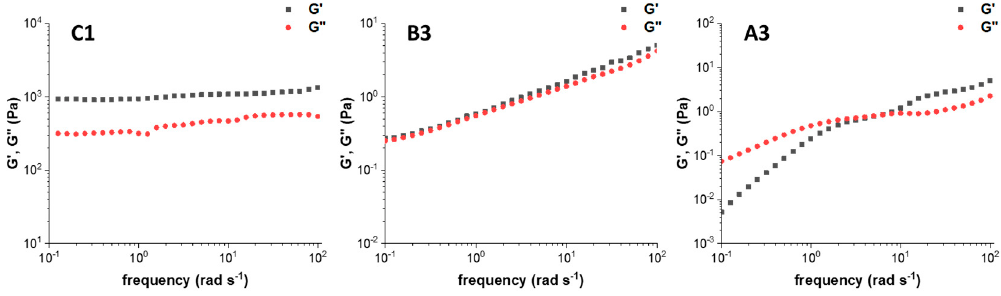
Figure 4. G’ (elastic) and G” (viscous) modules as a function of frequency of samples: C1 (TOUS-CNFs = 2.0%, CaCl 2 = 10 mM); B3 (TOUS-CNFs = 1.0%, CaCl 2 = 2 mM); A3 (TOUS-CNFs = 0.5%, CaCl 2 = 2 mM).